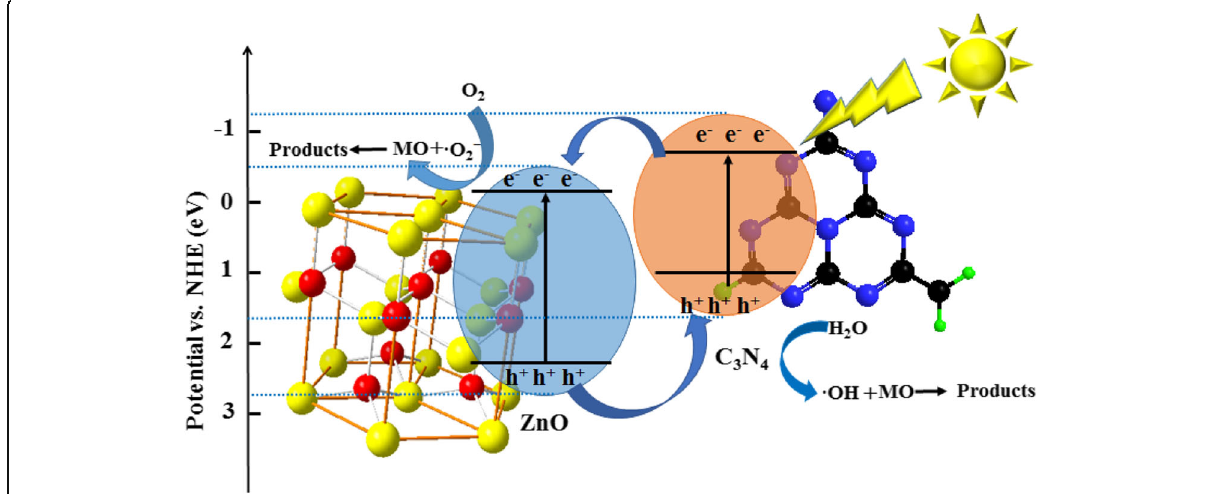
Fig. 14 Mechanism for photocatalytic degradation of monazo dyes on the ZnO/Fe 3 O 4 /g-C 3 N 4 -50%